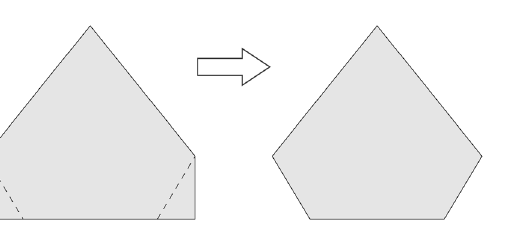
Figure 9. Conceived geometry of the final prototype 9 (in a (cid:31) shape with a cut in each